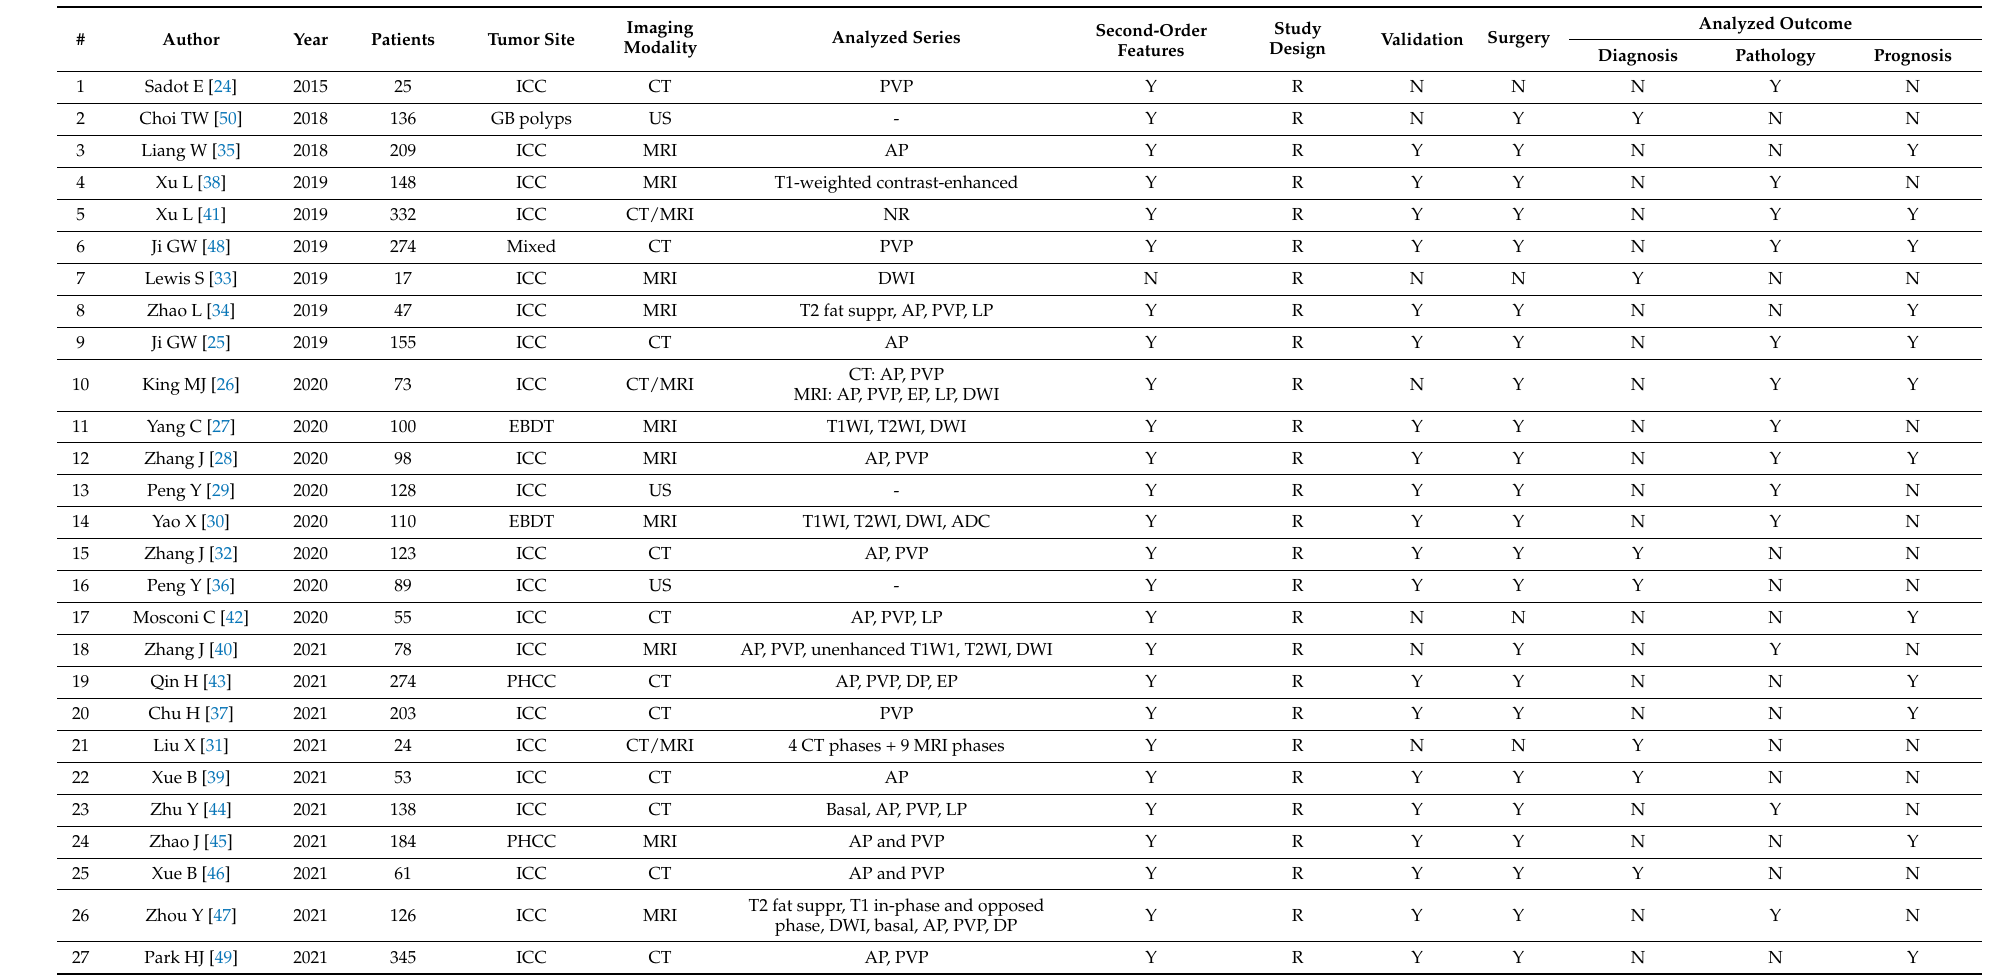
Table 1. Details of the analyzed